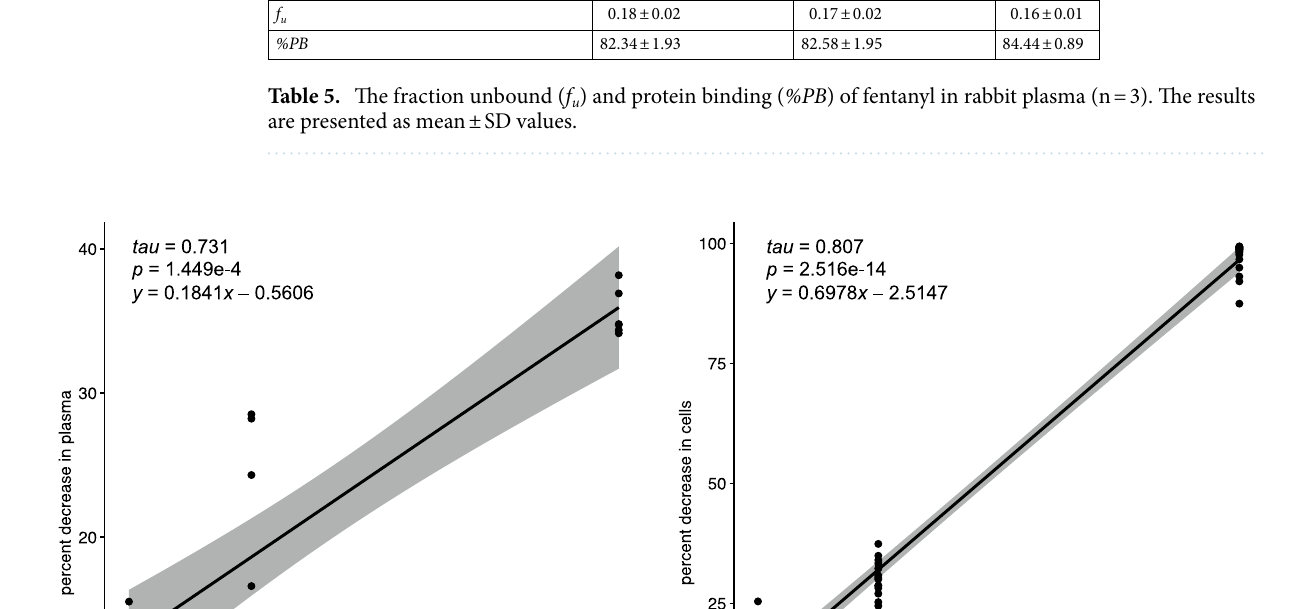
FTL concentration [ng/ml]